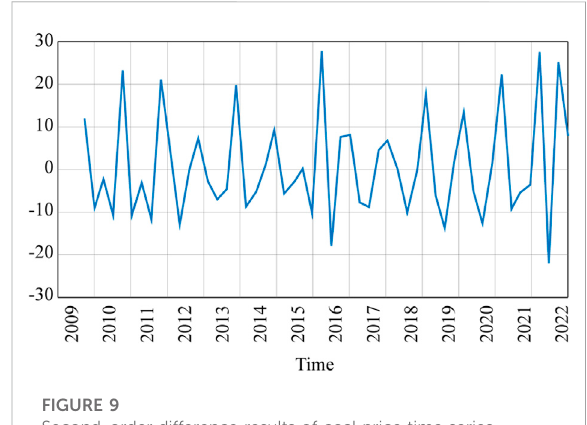
FIGURE 9 Second-order difference results of coal price time